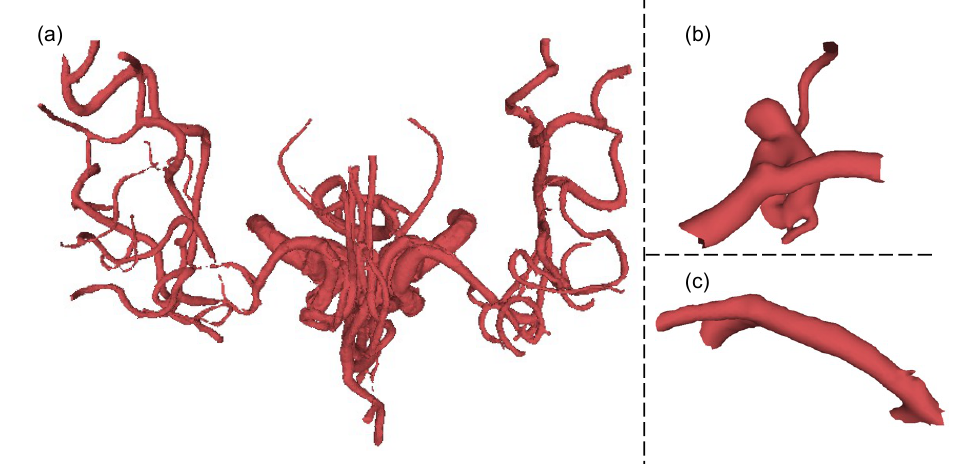
Figure 1. Examples of reconstructing ideal mesh from raw data in IntrA dataset. ( a ) Original raw data built from 2D images. ( b ) Smooth and complete part of aneurysms. ( c ) Smooth and complete part of the healthy